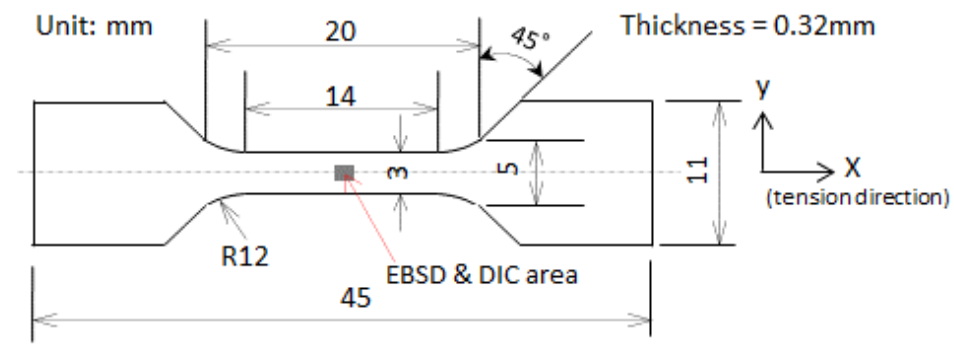
Figure 2. Specimen size.